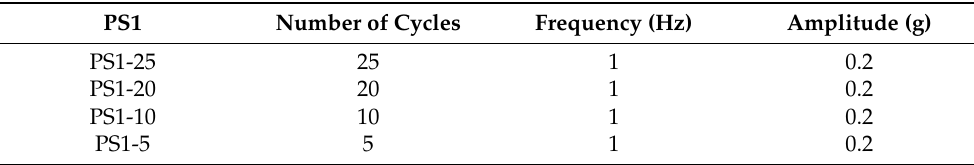
Table 4. Details of parametric study